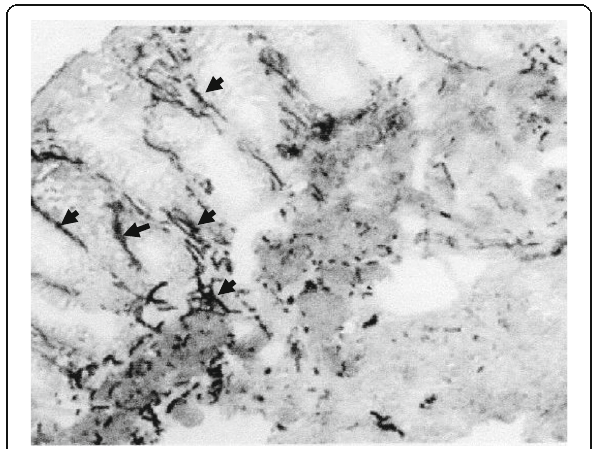
Fig. 2 Immunohistochemical staining of acetylcholinesterase (AchE) in the rectal mucosa showed increased AchE staining of nerve fibers in the mucosal lamina propria and muscularis propria (arrow), and no ganglion cells were observed in the submucosal Meissner ’ s